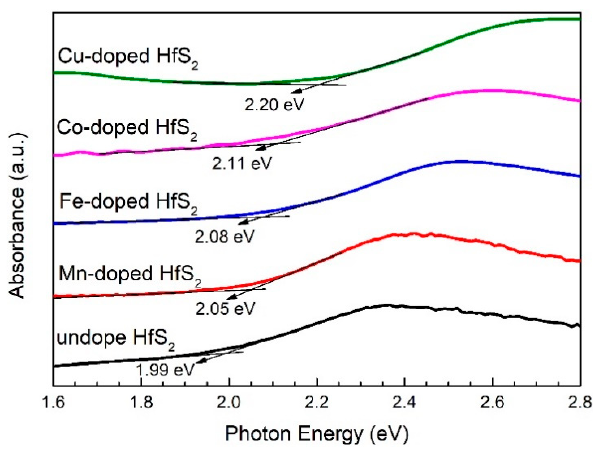
Figure 2. Absorption spectra of the pristine, Mn-, Fe-, Co-, and Cu-doped HfS 2 crystals.